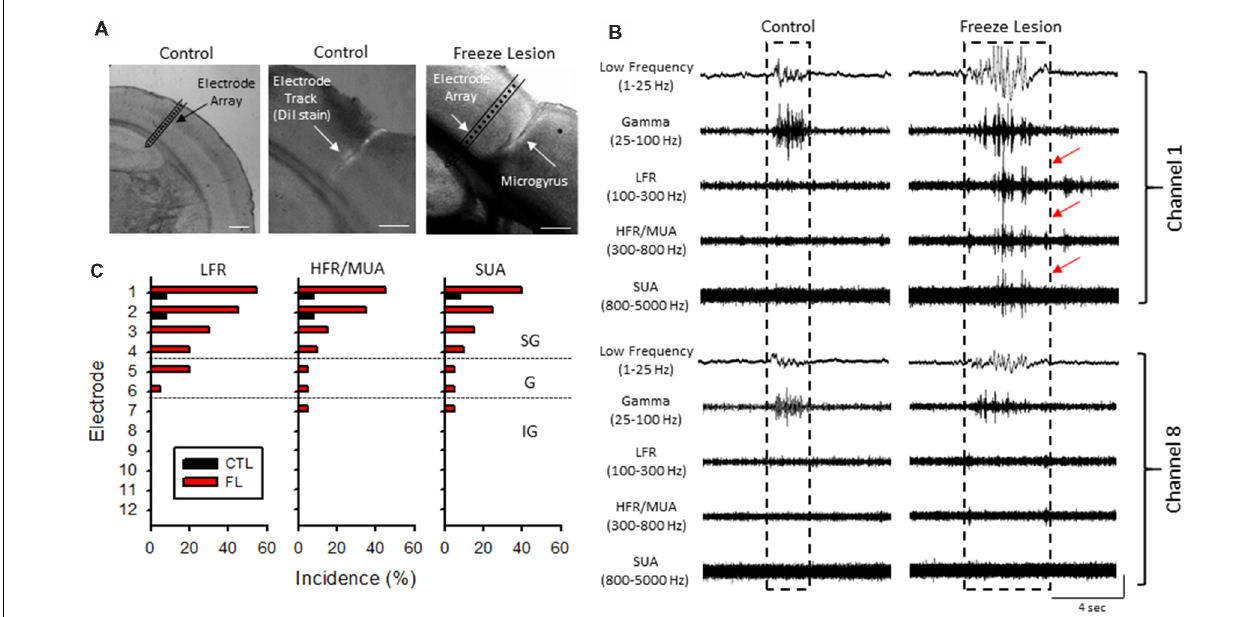
FIGURE 4 | Band-pass filter analysis of linear array recordings indicated an increase in HFOs during periods of B-S in freeze lesion animals in the upper cortical layers of the malformed cortex. (A) Representative coronal sections from the S1 cortical region of control and freeze lesion animals. Left panel indicates orientation of the linear micro-electrode array in comparison to the S1 cortex. The first 12 electrodes spanned the vertical extent of the cortex. Middle panel indicates the micro-electrode recording track as indicated by fluorescent DiI labeling of the linear array. Right panel demonstrates a freeze lesion induced microgyrus as compared to the position of a micro-electrode array. White scale bars = 400 µ m. (B) Representative samples of B-S events recorded from channels 1 and 8 of a control and freeze lesion animal. The waveforms were digitally filtered to evaluate spectral changes across defined bandwidth ranges; low-frequency, gamma, low-frequency ripple (LFR), HFR, and multi-unit activity (MUA). Increases in HFOs above 100 Hz were largely confined to the upper cortical layers near the site of the freeze lesion injury (red arrows). Amplitude scale bar = 0.4 mV (unfiltered signals) and 0.04 mV (filtered signals). Amplitude of filtered signals was increased to show detail of high-frequency events. (C) Percent of recordings exhibiting increases in HFOs between control and freeze lesion animals across three frequency bands. Electrodes 1–12 represent recordings from the upper to lower regions of the cortex, respectively. SG, supragranular; G, granular; IG, infragranular.